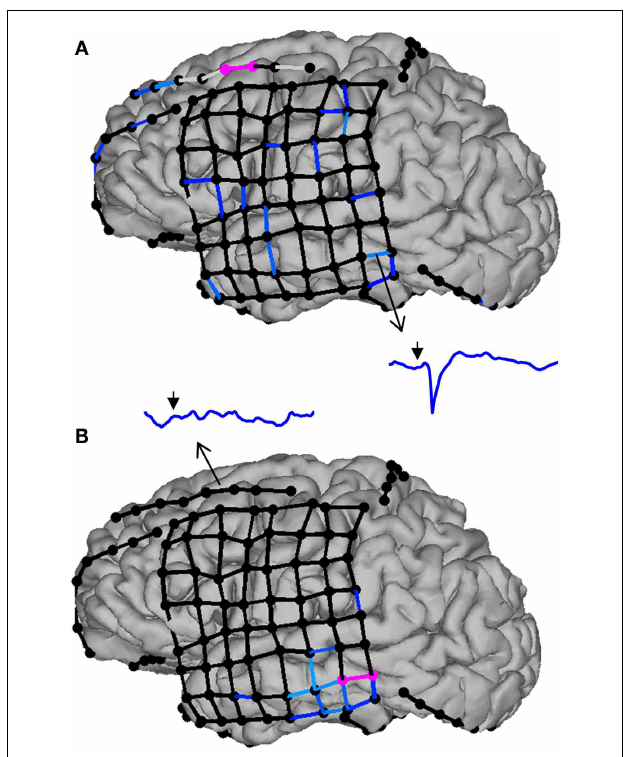
FIGURE 5 | Evoked effective connectivity reveals the directionality of neural connections in the human brain . In this example, subdural electrodes are represented by circles, and CCEP responses as lines linking bipolar electrode pairs. Missing (e.g., artifacted) data are indicated by light gray lines, sub-threshold (non-significant) responses by black lines, and significant responses by progressively lighter shades of blue. (A) Stimulation of the middle frontal gyrus (electrode pair colored in pink) triggers widespread responses in the frontal and temporal lobes, including the middle temporal gyrus (inset: CCEP waveform from 50ms before to 250ms after stimulation; the arrow indicates the time of stimulation). By contrast, stimulation of the middle temporal gyrus (B) does not evoke any significant response in the frontal lobe, illustrating that effective connectivity between remote brain structures is not necessarily